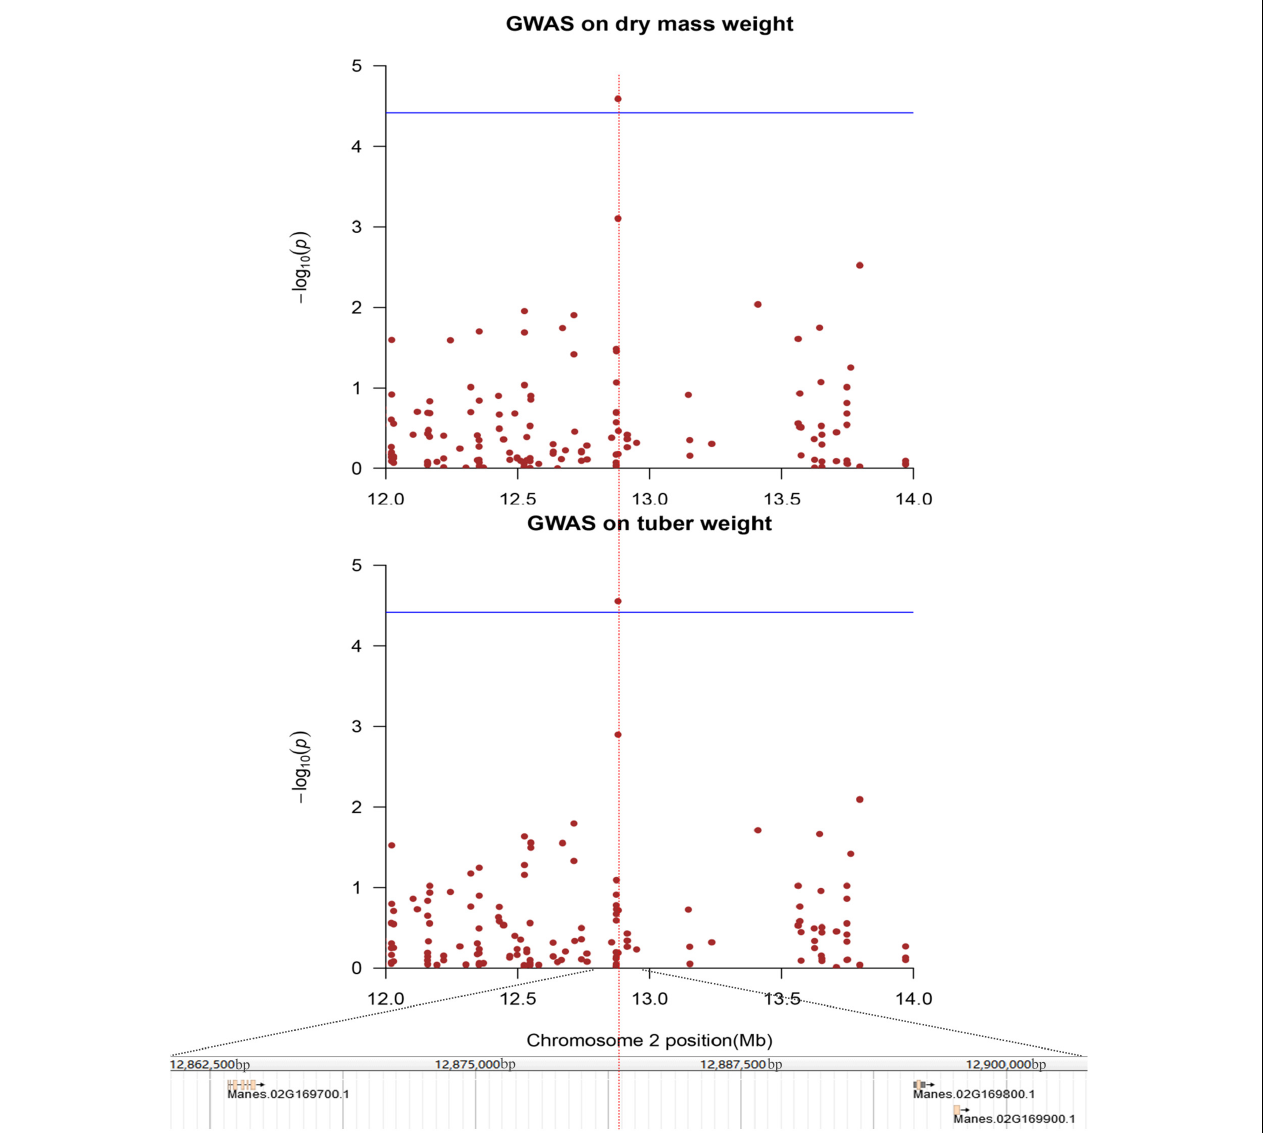
FIGURE 6 | Genome-wide association analysis of dry mass weight and storage roots weight in 158 cassava accessions using the SNPs detected on chromosome 2. Genomic position ( X -axis) is plotted against its significance expressed as –log 10 P value ( Y -axis). Genomic position covers 1 Mb on either side of the peak SNP, as shown in a black dashed vertical line. Genome-wide significance threshold is depicted as a blue horizontal dashed line. Annotated candidate genes are indicated in pink boxes below the